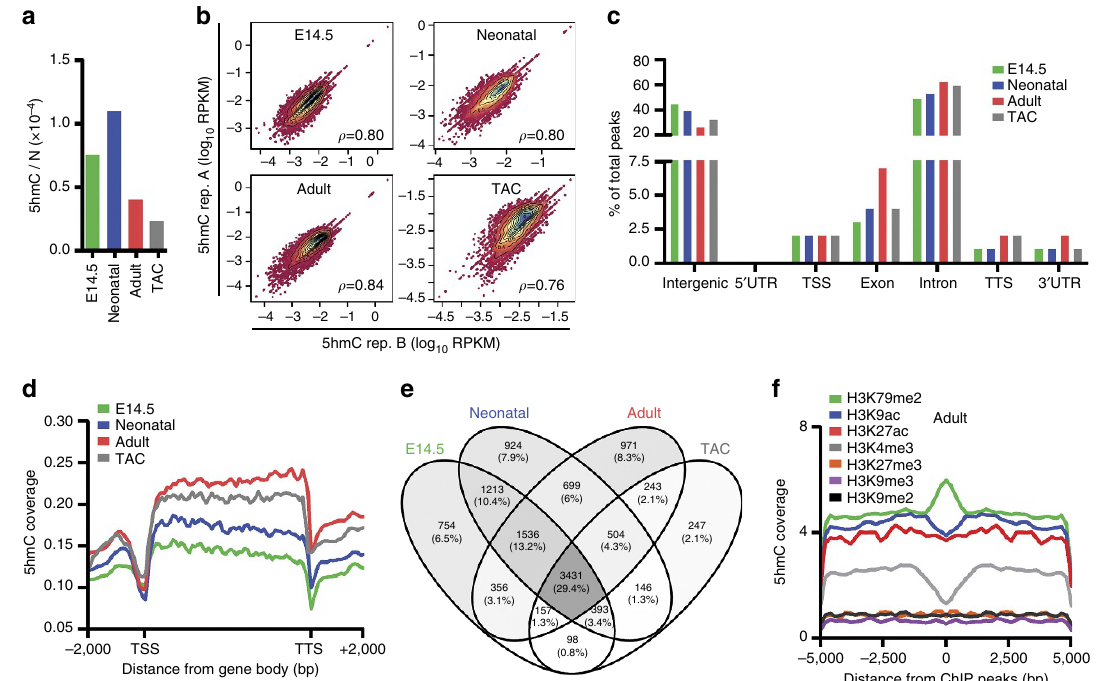
Figure 1 | Genomic distribution of 5-hmC in mouse CMCs. ( a ) Quantification of global 5-hmC in embryonic (E14.5), neonatal, normal adult (Adult) and hypertrophic adult (TAC) CMCs. ( b ) Density plots illustrating the correlation of the GB 5-hmC level in biological replicates (rep. A and rep. B) of embryonic (E14.5), neonatal, normal adult and hypertrophic (TAC) CMCs. For each plot, Pearson’s correlation coefficient r is given. Intragenic levels of 5-hmC were quantified by counting the number of reads falling onto genes from the TSS to the TTS. Read number was normalized to library size and gene length (RPKM). ( c ) The presence of the 5-hmC peaks overlapping in the biological replicates on different genomic elements. TSS, transcription start site; TTS, transcription termination site; UTR, untranslated region. ( d ) Average 5-hmC coverage across the GB of all reference genes (UCSC version mm10) at each studied point. ( e ) Venn diagram of the number of genes associated with the identified peaks at the four studied points; peaks overlapping with exons and introns were considered for the analysis. ( f ) Profiles of 5-hmC distribution around the H3K79me2, H3K9ac, H3K27ac, H3K4me3, H3K27me3, H3K9me3 and H3K9me2 peaks identified with MACS software in adult known to undergo ‘neonatal-like’ reprogramming in hypertrophic CMCs (Supplementary Fig. 2c,d).